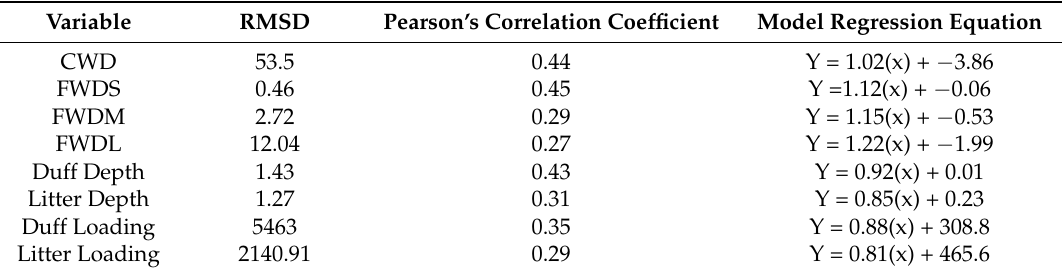
Figure 8. Variable of importance plot displaying ranked importance of predictor variables from random forest classifications used to predict each DWM response category for interior Douglas-fir stands throughout the Intermountain West, USA. Due to the continuous nature of the response variables, model ranking of the importance of predictor variables is delineated by the percent increase in mean square error (%MSE). Higher percent MSE values indicate variables that are more important to the classification. Variable codes are defined in Supplementary File S1. Table 3. Random forest model validation results including regression equations for each DWM, duff, and litter response variable of